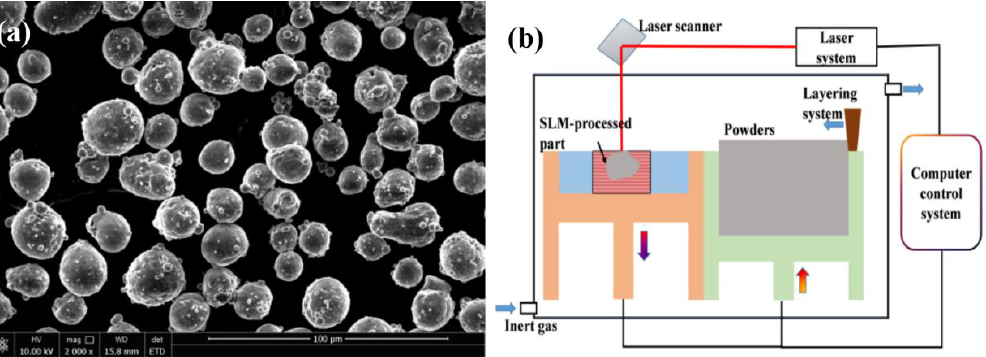
Figure 1. Morphologies of the homogeneously mixedAl 2 O 3 /AlSi10Mg composite powders processed by ball milling ( a ); the schematic of SLM processing ( b ).